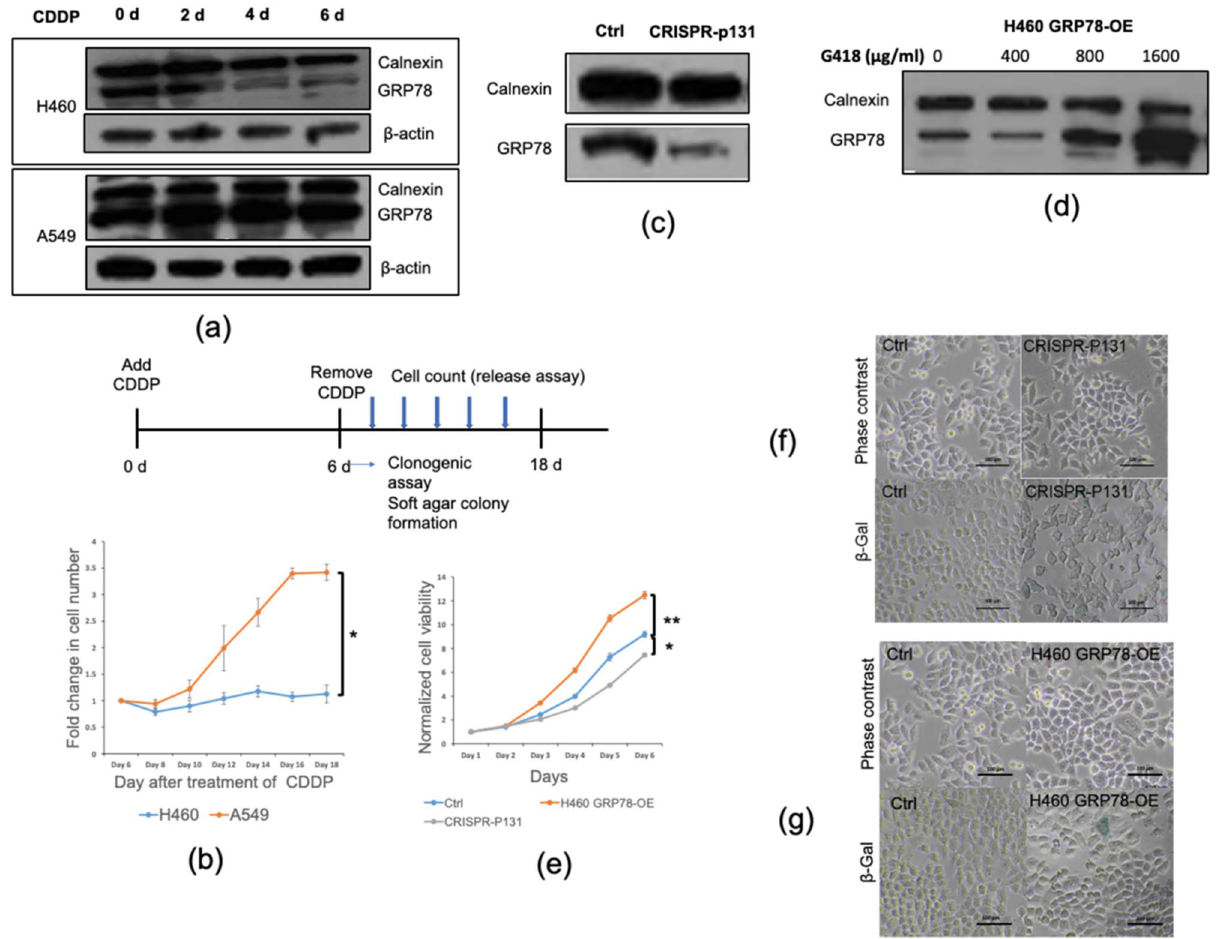
Figure 4. GRP78 primes the senescence cells for cell cycle re-entry when CDDP was removed. ( a ) Time-course analysis of the GRP78 protein expression in H460, A549 cells treated with CDDP at 5 µM. ( b ) Representative proliferation curves of H460, A549 cells treated with CDDP for 6 days then untreated for the remaining days (release) until day 18 ( c ) GRP78 Protein levels in H460 CRISPR-P131 cells by western blot analysis. ( d ) GRP78 Protein levels in H460 GRP78-OE cells selected by G418 (the full-length blots are presented in Supplementary Figures). ( e ) Proliferation assay of H460 CRISPR-P131, H460 GRP78-OE cells compare with control by monitoring for consecutive 6 days. (initial cell concentration is 10 3 cells/well) ( f,g ) Cell morphology and senescence-associated β-galactosidase staining of H460 CRISPR-P131 and H460 GRP78-OE cells. Data was presented as representative curves of at least three independent experiments. The scale bar in figure ( f,g ) is 100 µm. *Denotes p < 0.05, **Denotes p <